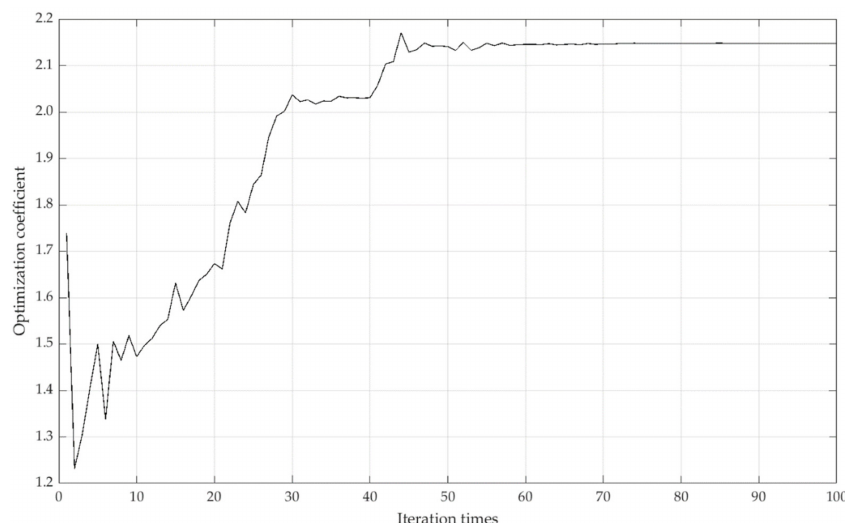
Figure 6. Iteration trend of optimal the projection value of local emergency resilience.